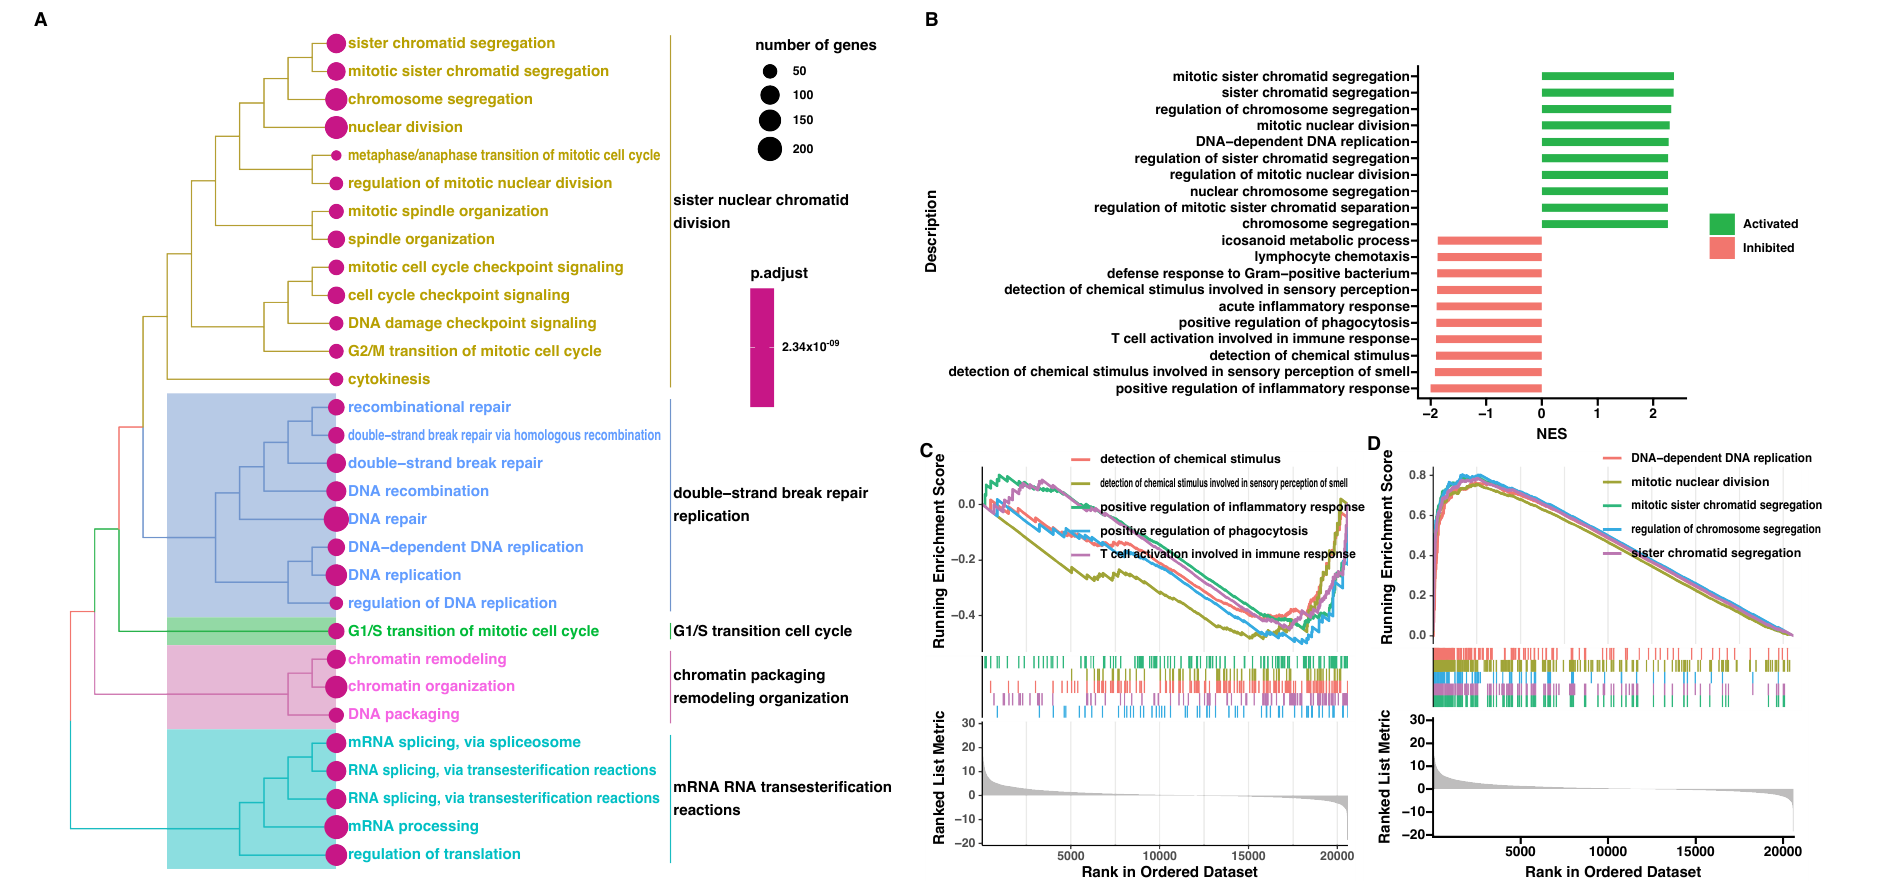
Figure 8. Gene set enrichment analysis (GSEA) from the comparison of patients with low and high ZWILCH expression, based on GSE10927. Clustering of enriched gene sets into common functional groups, each cluster is marked with a different color ( A ). The barplot with ten of the most activated and inhibited gene terms according to the normalized enrichment score values ( B ). Detailed enrichment plots for the five most inhibited and the five most activated gene sets, showing the profile of the running NES score and the positions of the genes on the rank − ordered list ( C , D